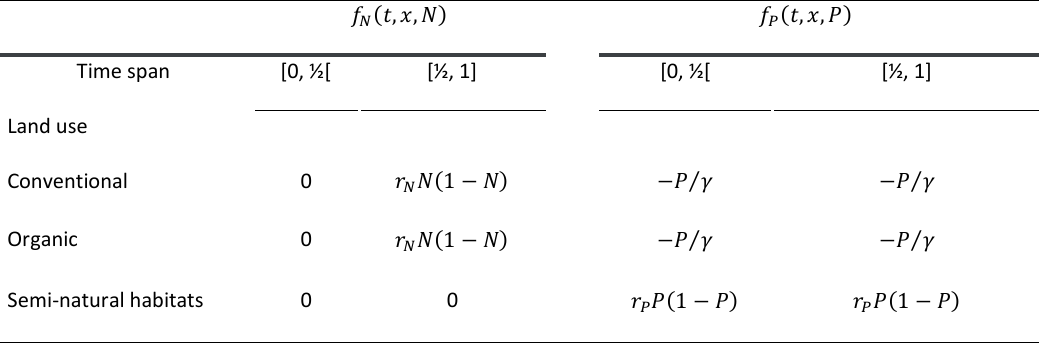
Table 2 - Values of the growth functions 𝑓 𝑁 (𝑡,𝑥, 𝑁 𝑡 (𝑥)) and 𝑓 𝑃 (𝑡,𝑥,𝑃 𝑡 (𝑥)) . 𝑟 𝑁 is the pest intrinsic growth rate in the crops in the absence of pest management, 𝛾 the natural enemy life expectancy in the absence of resources and 𝑟 𝑃 the natural enemy birth rate in semi-natural habitats. 𝑓 𝑁 (𝑡,𝑥,𝑁) 𝑓 𝑃 (𝑡,𝑥, 𝑃) Time span [0, ½[ [½, 1] [0, ½[ [½, 1]